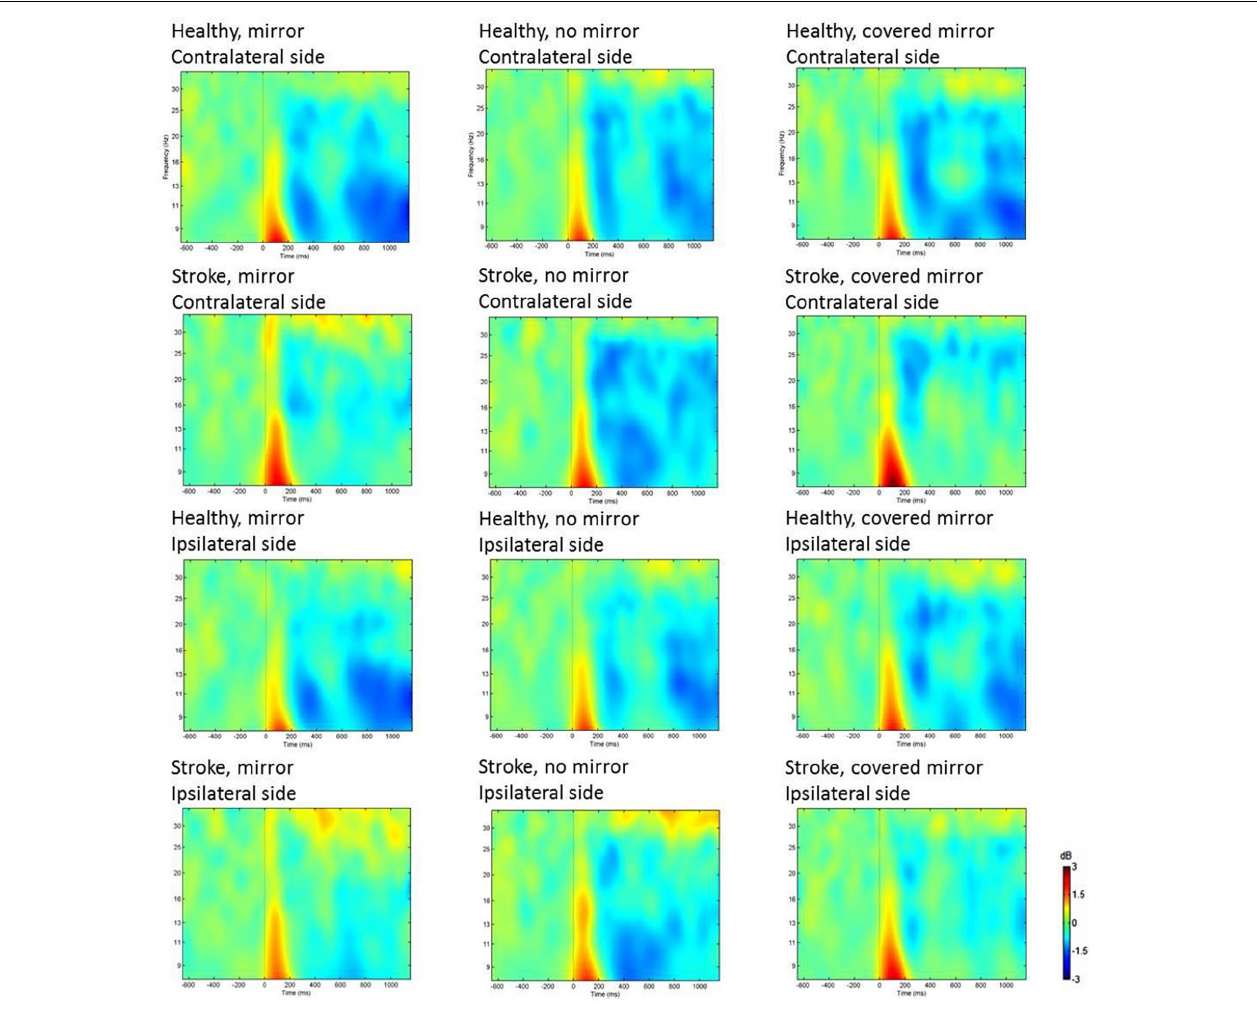
FIGURE 2 | Comparison of ERSPs at electrodes C3 (contralateral motor area) and C4 (ipsilateral motor area) in three unimanual hand movement task conditions: with mirror, with no mirror, and with covered mirror, in two groups: stroke patients and healthy controls, with ERD presented in color